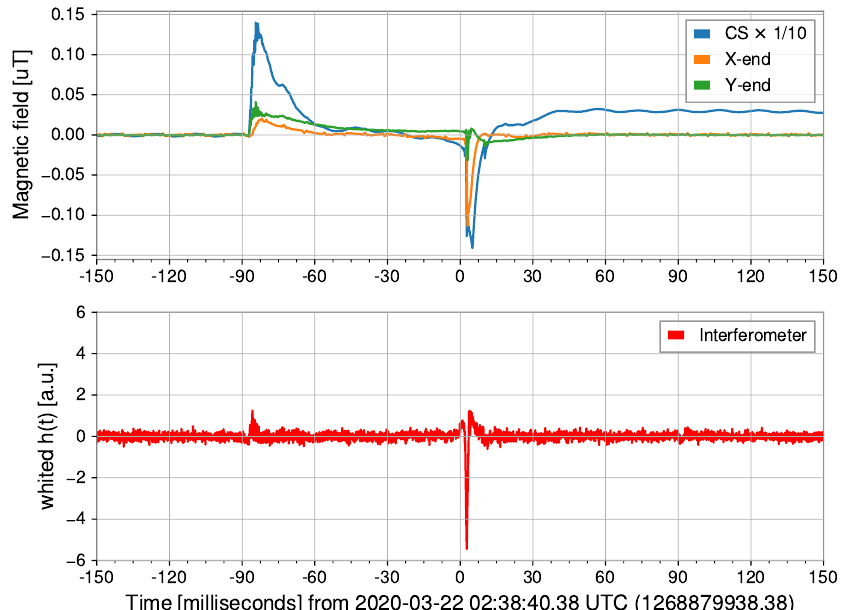
Figure 17. Time–series data of the magnetometers inside the KAGRA site ( top ) and KAGRA’s main interferometer (whitened strain signal) ( bottom ) for nearby lightning. The origin of the horizontal axis (22 March 2022, 02:38:40.38) is the time of a lightning strike. For the magnetometers, the DC value of geomagnetism ( ∼ 50 µ T) is subtracted. Reprinted with permission from Ref. [56], ©2021 IOP